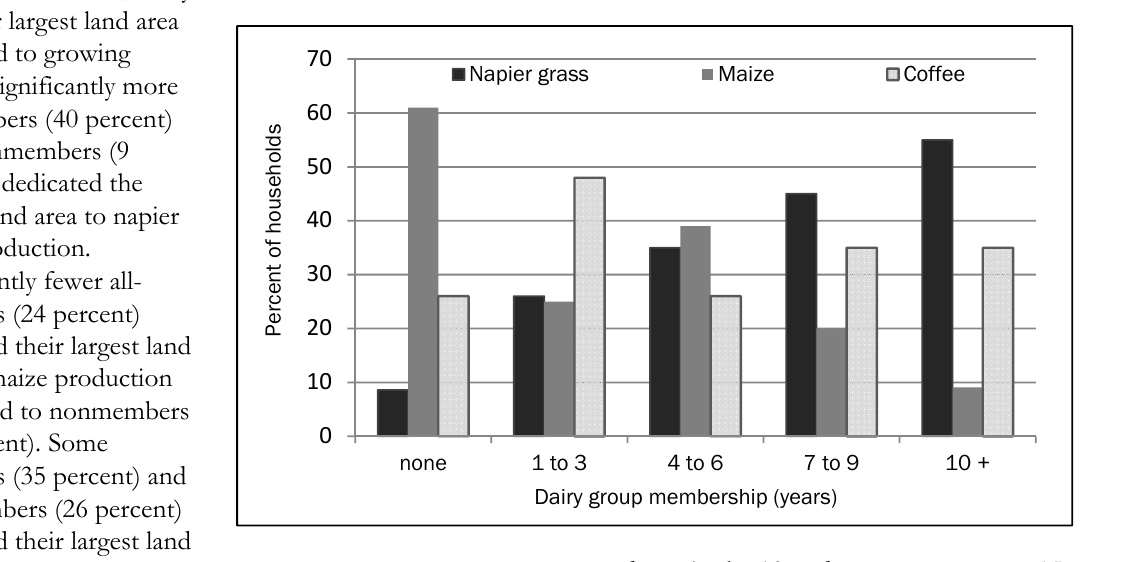
Figure 1. Crop Occupying the Largest Farm Area, by Membership